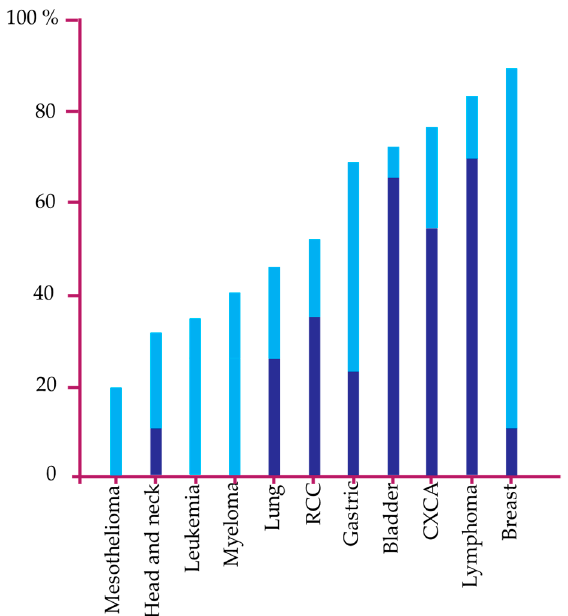
Figure 3. Percentages of DAPk gene methylation in different tumors. Minimal and maximal percentage of DAPk methylation is represented in dark blue and light blue, respectively, as identified by different studies [64–74]. RCC: renal cell cancer, CXCA: cervical cancer.